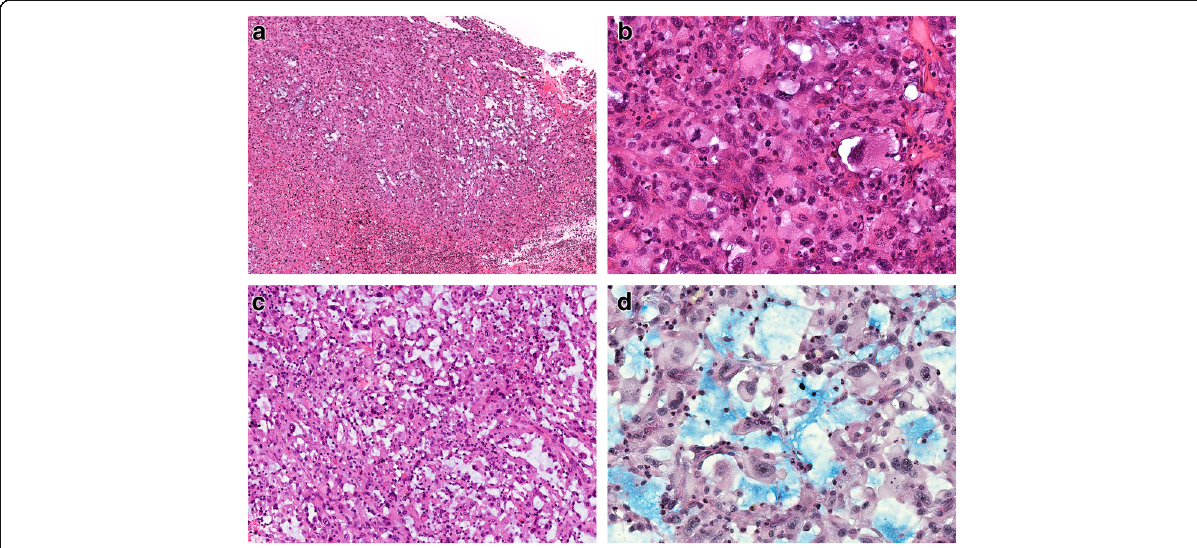
Fig. 2 a On low power magnification, the tumor consisted of “ vasoformative ” areas admixed with more solid areas. b Solid areas constituted by highly atypical epithelioid cells. c “ Vasoformative ” areas characterized by vascular channels lined by plumped atypical cells, lacking of red blood cells. d Vascular channels containing Alcianblue positive mucoid substance. a : 40×, H-E; b : 200×, H-E; c : 100×, H-E; d : Alcian-PAS,